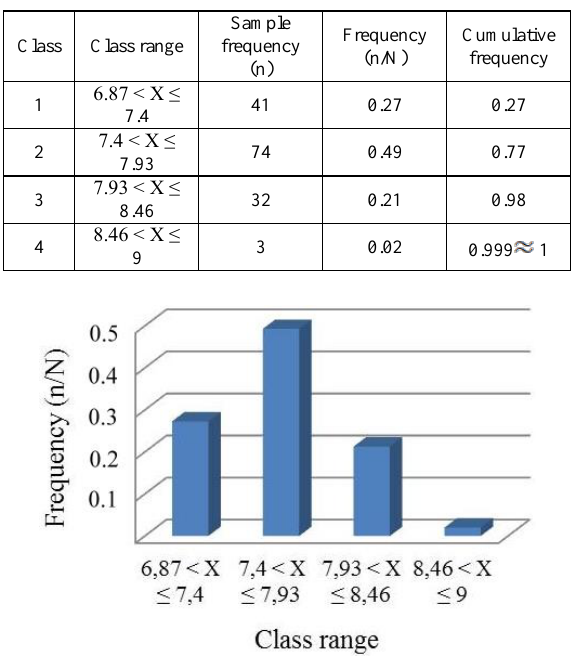
Figure 5. Distribution of pH values Daily operating